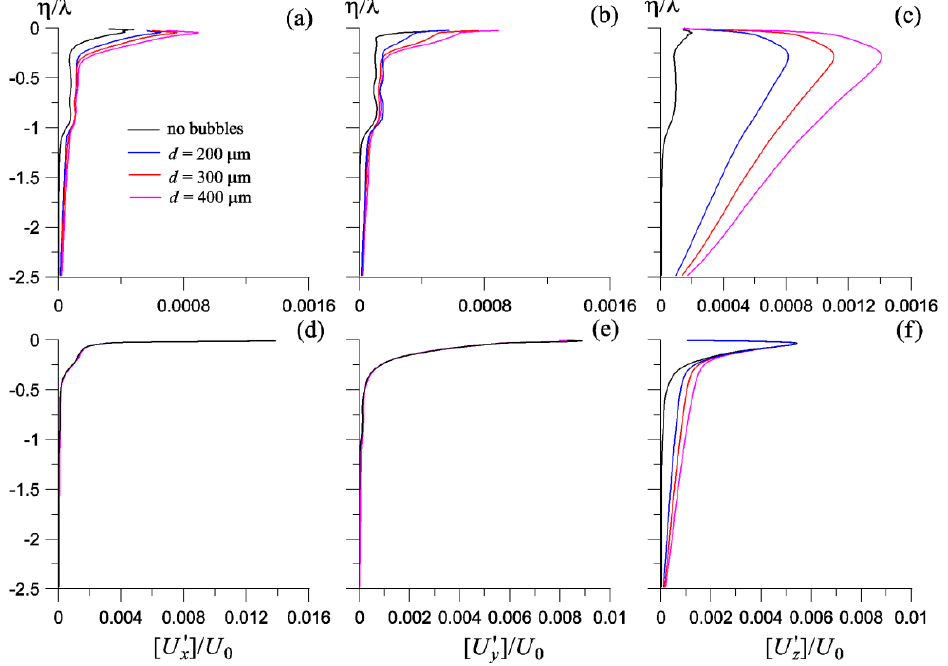
Figure 4. Mean profiles of water velocity fluctuations obtained using DNS with wave slope ka = 0.2 and different bubbles diameter, d . Panels ( a – c ) are for the case U d = 0 and panels ( d – f ) are for the non-zero surface drift